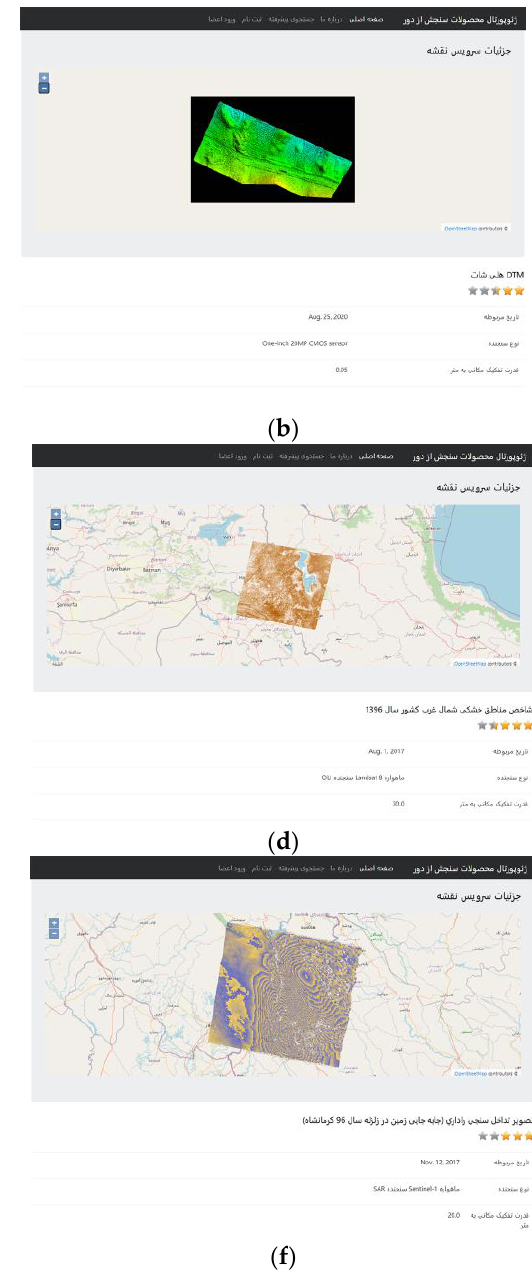
Figure 13. Examples of crowdsourced EO products in the implemented prototype system; ( a ) unmanned aerial vehicle (UAV)-based RGB image of a private garden in Mashhad, Iran, ( b ) UAV-based digital terrain model (DTM) image from a rural area near Tangal-e Mazar village, Khorasan Province, Iran, ( c ) modified normalized difference water index (MNDWI) image for an area located in West Azerbaijan and West Azerbaijan Provinces, Iran, ( d ) temperature condition index (TCI) image for an area located in West Azerbaijan and West Azerbaijan Provinces, Iran, ( e ) classified image of a district in Tabriz, Iran, ( f ) interferogram image for land surface displacement in an area in Kermanshah Province,